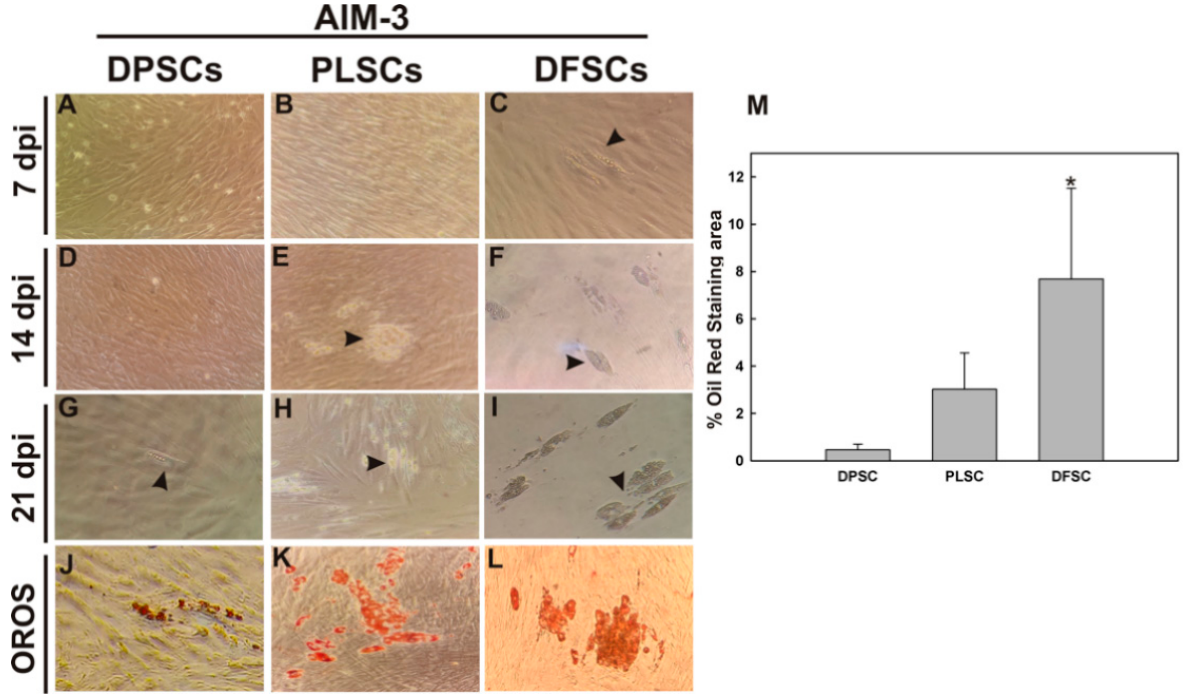
Figure 6. Lipid droplet generation during the adipogenic induction of dental tissue-derived mesenchymal stem cells. Human dental follicle stem cells (DFCSs, A , D , G , J ), dental pulp stem cells (DPSCs B , E , H , K ), and periodontal ligament stem cells (PLSCs, C , F , I , L ) were induced toward adipogenic differentiation by using adipogenic induction medium denominated AIM-3. Black arrowheads indicate the presence of lipid droplets (LDs) detected in the cells at seven and 14 days after induction (dai) in DFSCs ( C ) and PLSCs ( E ), respectively, and at 21 dai in DPSCs ( G ). Adipocyte cells with LDs in red color ( J – L ) were visible as indicated by the Oil Red O staining (OROS). ( M ) Quantification of OROS of DFSCs, DPSCs, and PLSCs as a proportion to the Oil Red O positive surface in percentages after 21 days in AIM-3. Error bars represent the standard deviation of the mean from three independent experiments. Asterisks (*) represent significance with respect to the adjacent cell group ( p < 0.05).